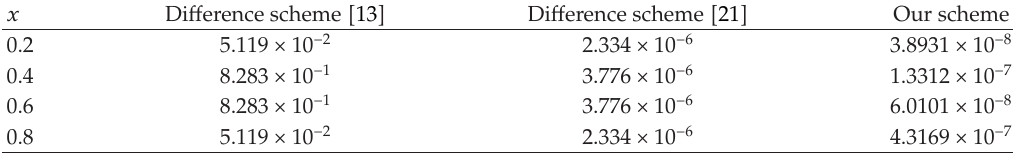
Table 4: The absolute error of Example 4.2 for di ff erence schemes and our scheme at t (cid:3) 0 . 8.